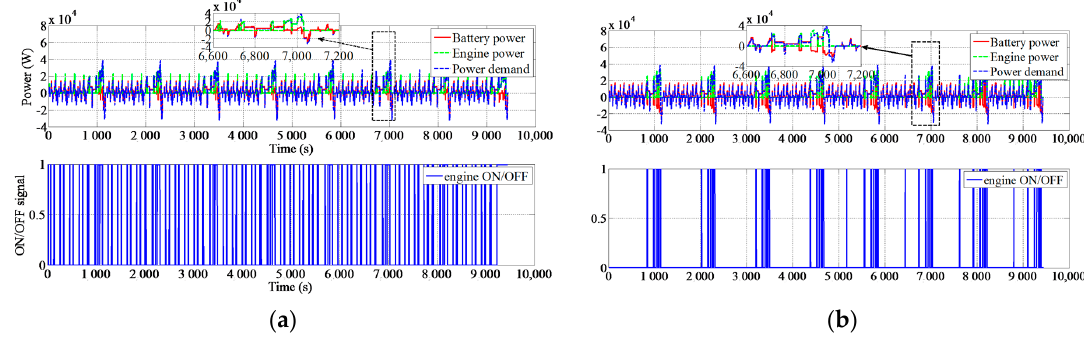
Figure 11. ( a ) The result based on dynamic programming (DP) when eight NEDC cycles are simulated; ( b ) The result based on convex optimization and SA when eight NEDC cycles are simulated.